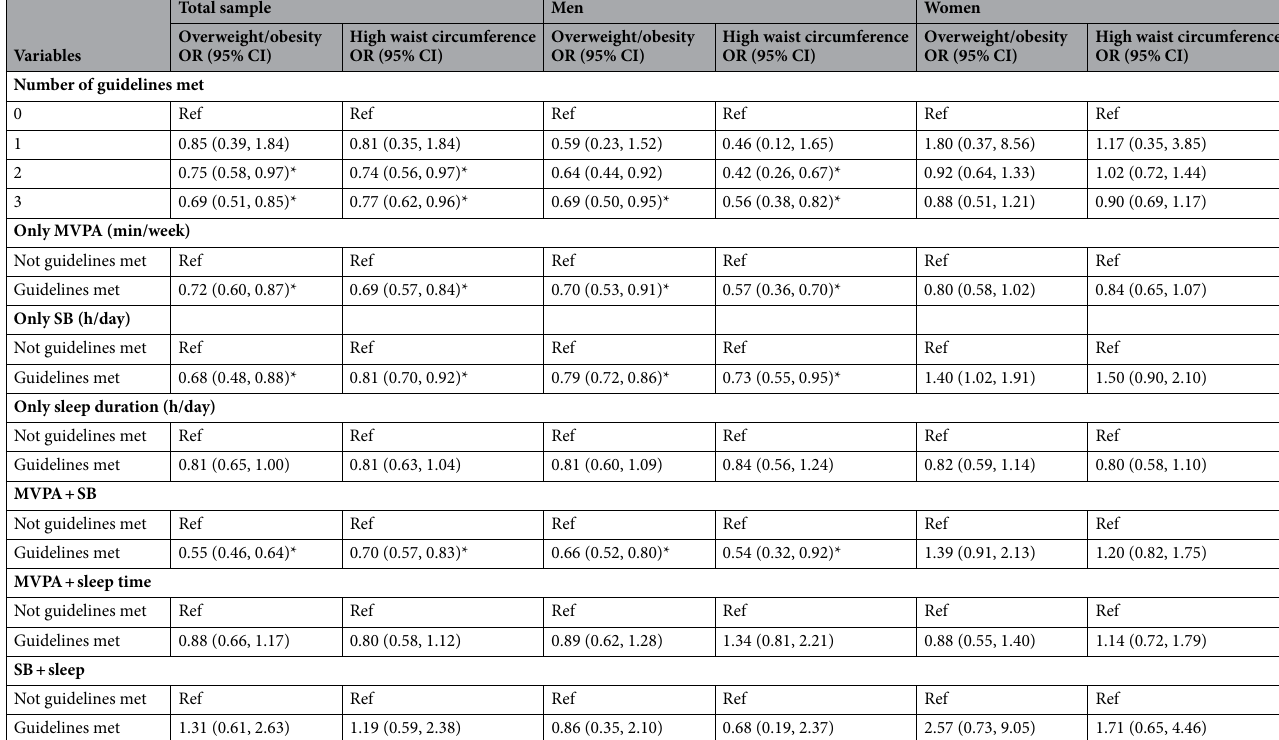
Table 4. Adjusted odds ratios (OR [95% CI]) for the relationship between the 24-h movement behavior recommendation met and markers of adiposity by sex. The models were adjusted for age, education level, marital status, and country. OR, odds ratio; 95% CI, 95% confidence interval; MVPA, moderate-to-vigorous physical activity; SB, sedentary